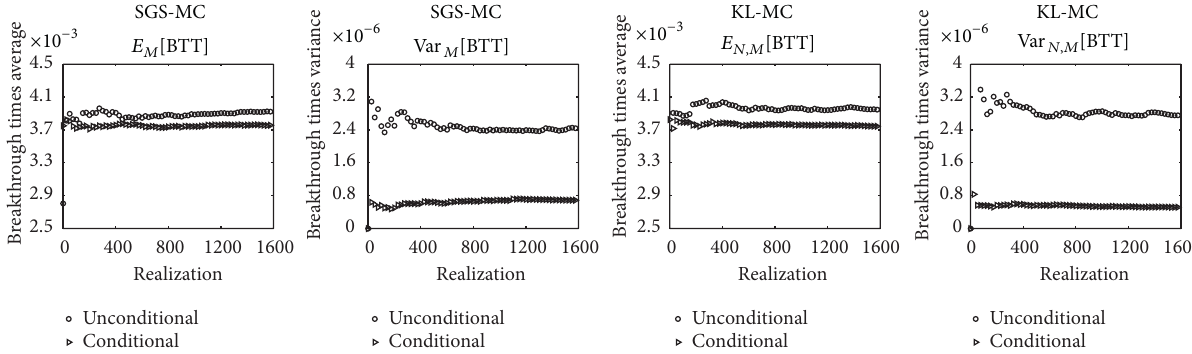
Figure 9: Example from Section 4.1. Convergence of expectations and variances of breakthrough times BTT depending on the number of realizations 𝑀 obtained with SGS-MC and KL-MC. Each figure shows results for 𝑁 𝑚 = 0 and 𝑁 𝑚 = 30